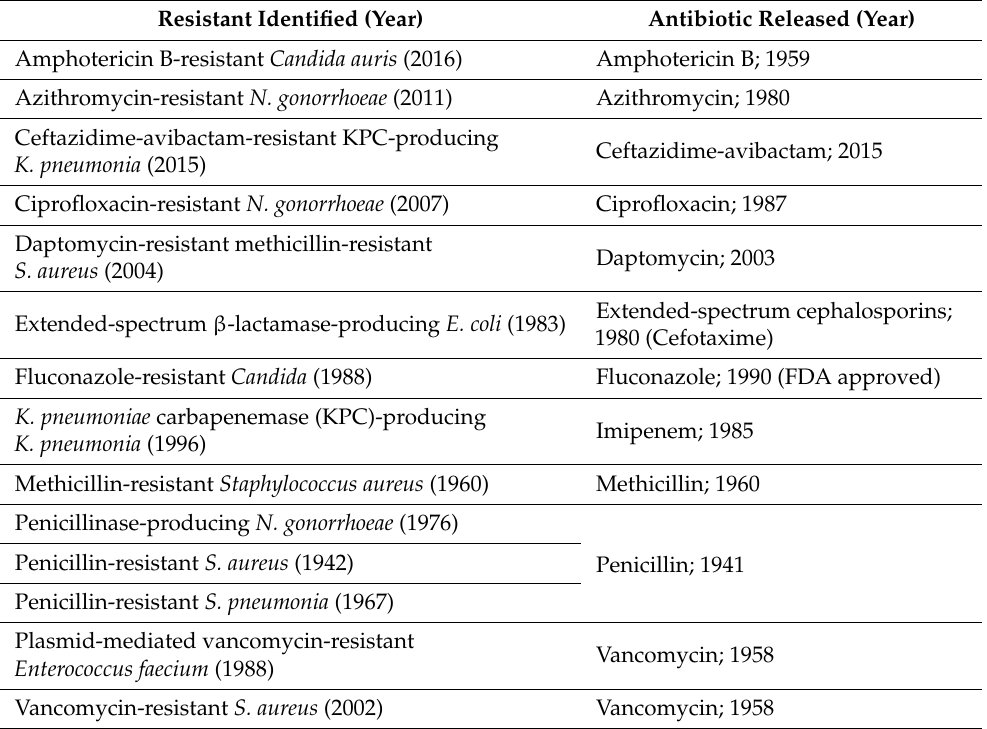
Table 2. Selected microbes that developed drug resistivity coupled with the release year of antibiotic